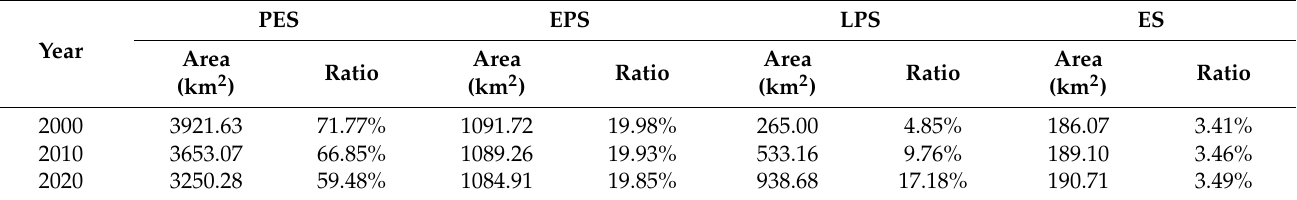
Table 2. The area ratio of the PLES in the UCC from 2000 to 2020.